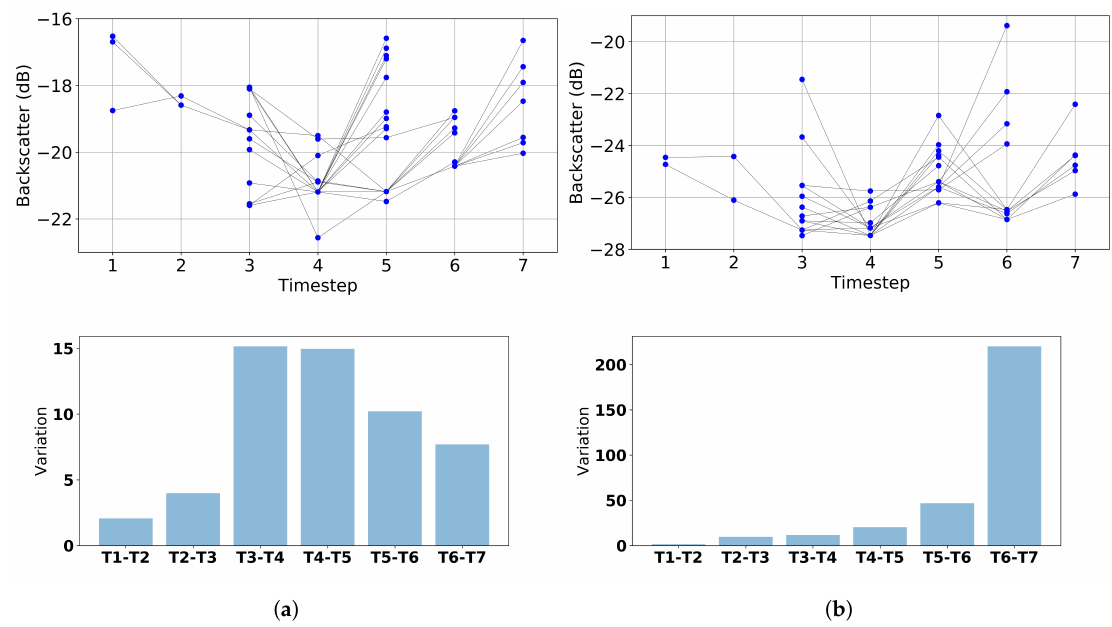
Figure 20. Temporal profile and variation VV versus VH polarisation for descending SITS in the dynamic zone. ( a ) Descending VV. ( b ) Descending